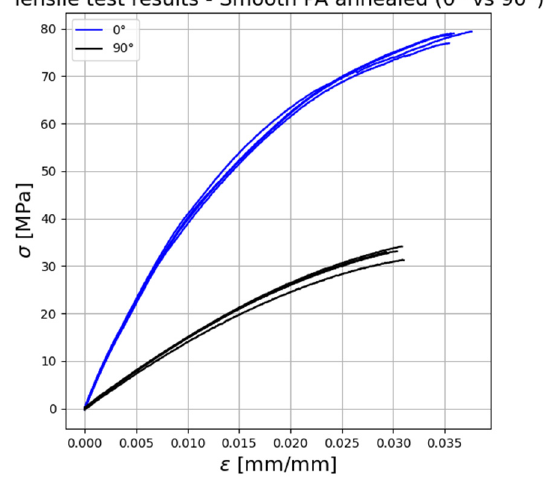
Figure 7. Stress–strain relationship of chopped FRP with different deposition patterns. Table 3. Tensile test results—Chopped FRP.